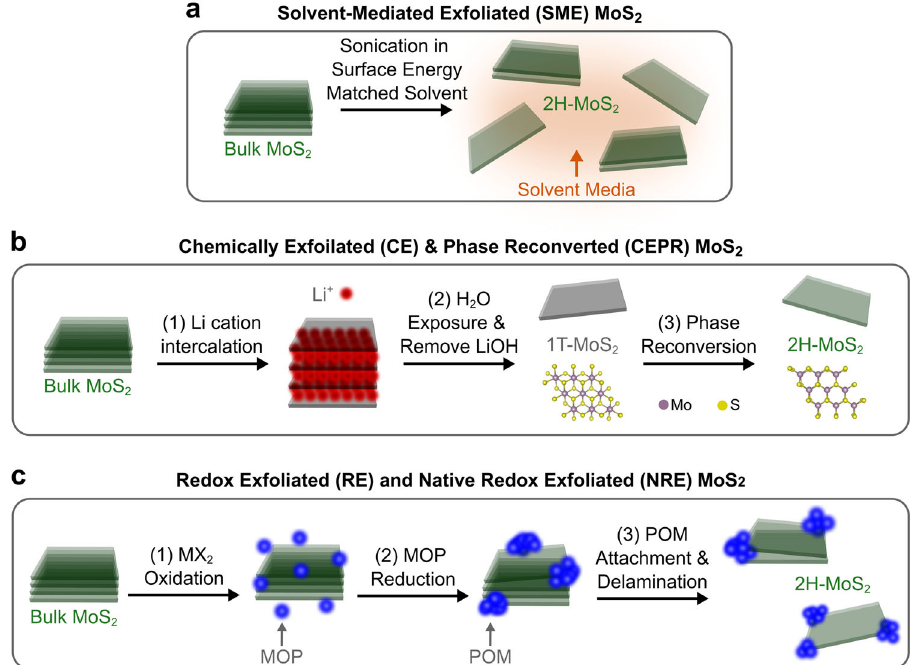
Fig. 1 Exemplary liquid phase exfoliation methods used to prepare thin fi lms. Schematics are shown for ( a ) SME MoS 2 , ( b ) CEPR MoS 2 , and ( c ) RE and NRE MoS 2 . Note that ( c ) shows the generalized scheme for RE MoS 2 . In comparison, NRE MoS 2 is prepared without synthetic oxidation and reduction reagents (e.g., such as with cumene hydroperoxide and hydroquinone, respectively) and represents the fi rst step in ( c ) with native CVT MoS 2 powder conditions. NRE MoS 2 is considered part of the redox exfoliation methodology due to the formation of native MOP species. These four exfoliation methods produce the four different procedure-dependent semiconducting exfoliated MoS 2 assessed